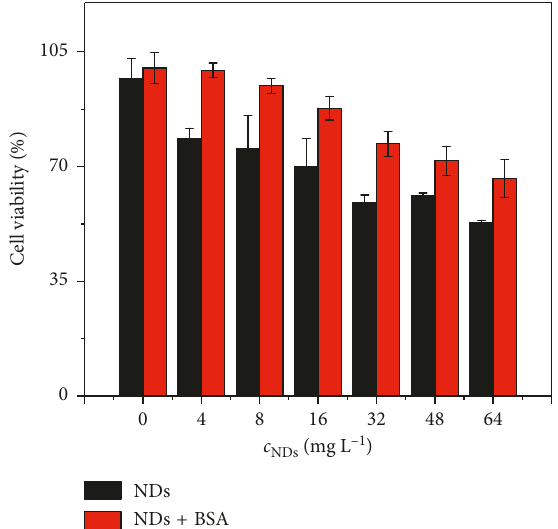
Figure 5: Viability of BEAS-2B cells exposed to various concen- trations of NDs for 24h ( c NDs : 0, 4, 8, 16, 32, and 64mg · L − 1 ; c BSA : 6.0 μ M; n �